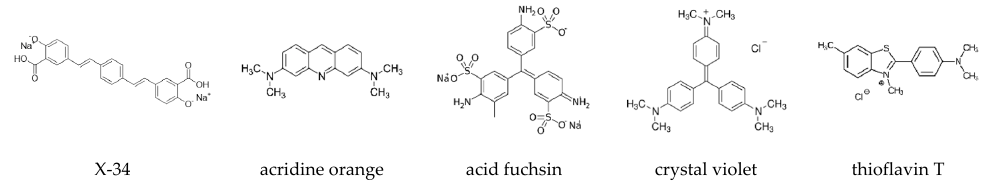
Figure 3. Summary of dye structures. Chemical structure of dyes in this study with indications of oligomer selectivity, together with the reference amyloid indicator dye Thioflavin T.